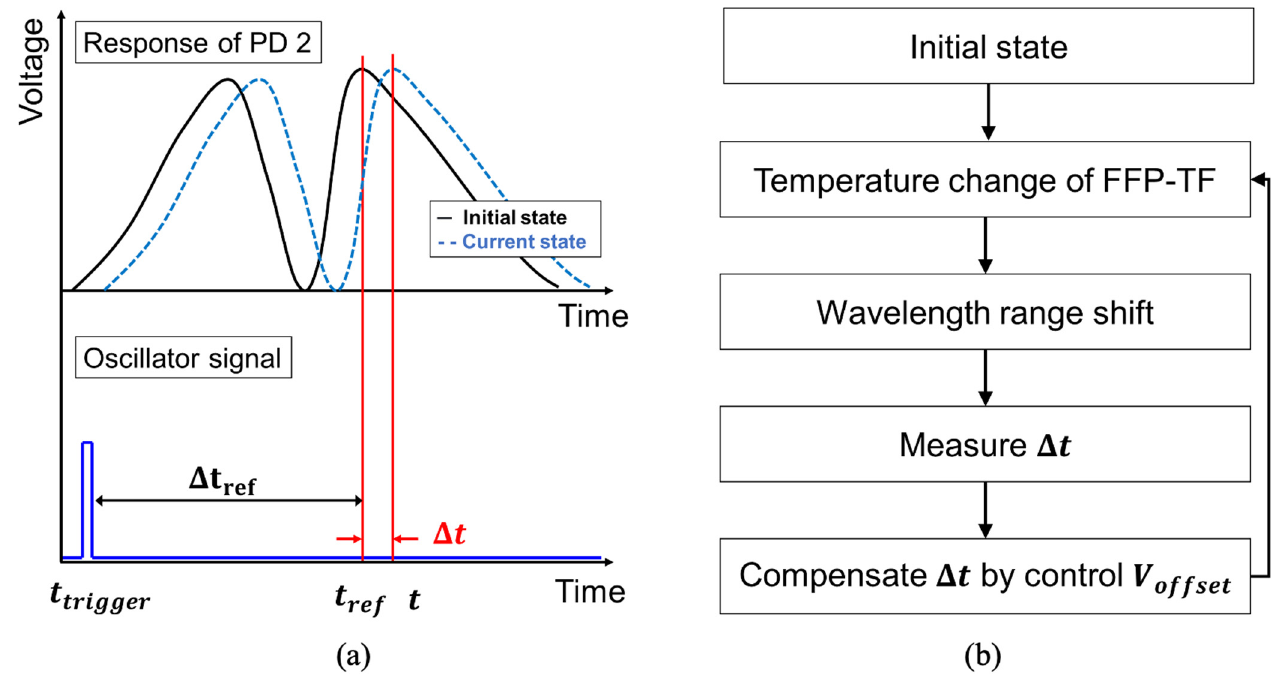
Figure 2. ( a ) The peak position t ref of the WSL waveform initial state in the temporal domain was measured based on the oscillator trigger signal. The peak wavelength position was shifted to point t by altering the external and internal temperatures of the FFP-TF, and ( b ) a schematic of the algorithm based on closed-loop control of the WSL output via the peak position of the forward or backward scan (PD: photo-detector).